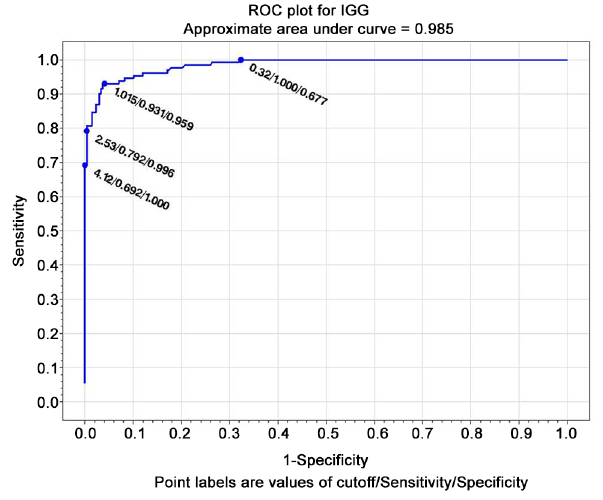
Figure 2. ROC curve for Bordier ELISA (composite reference standard).